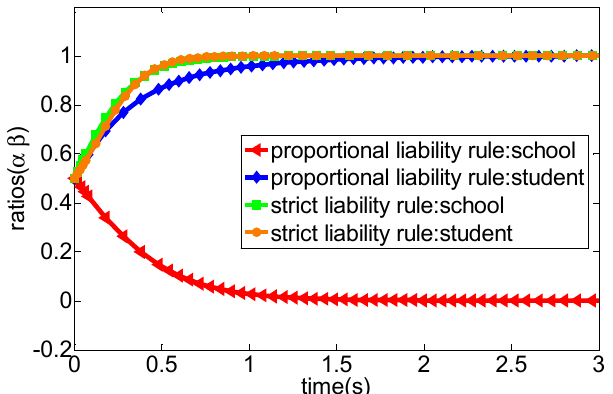
Figure 4. The evolution process of the system game strategy under the condition of high accident loss (case 3).